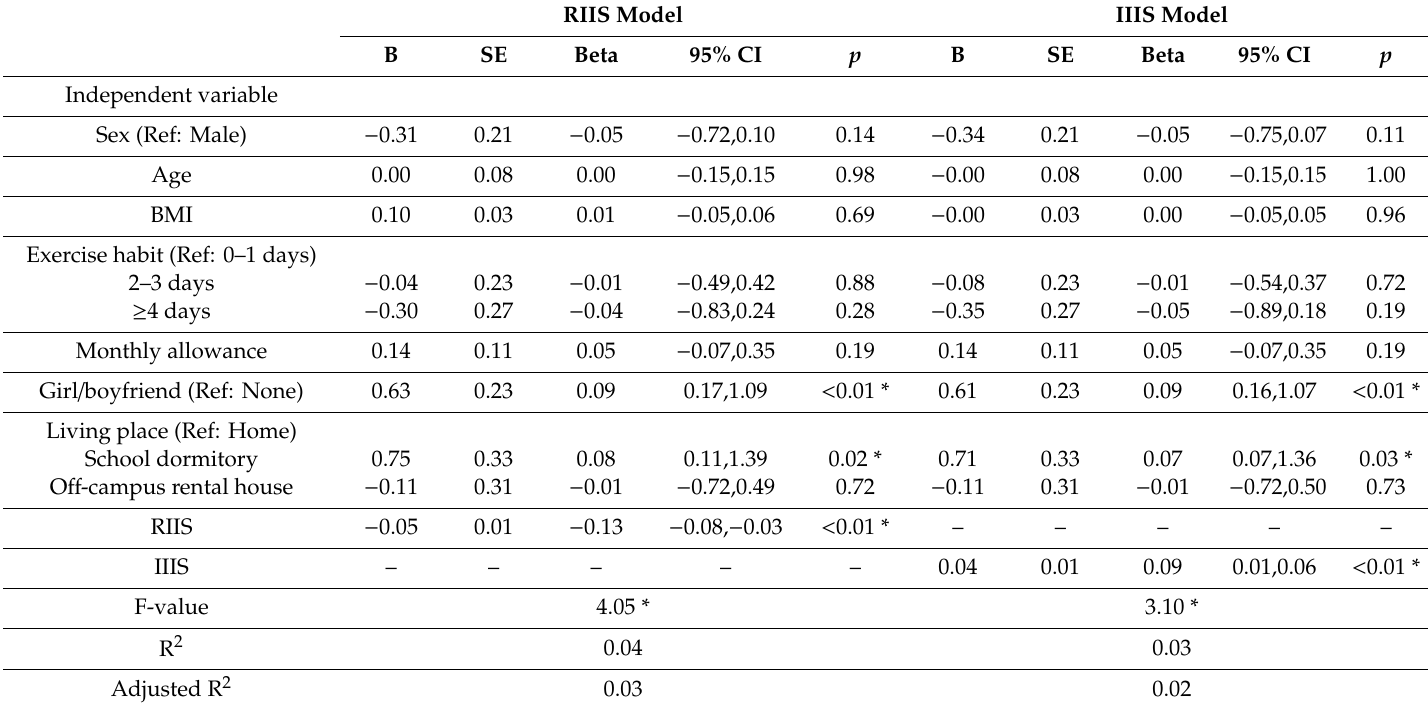
Table 3. Multiple regression analysis on factors a ff ecting sleep quality (i.e., Pittsburgh Sleep Quality Index; PSQI) by interpersonal interaction (real and